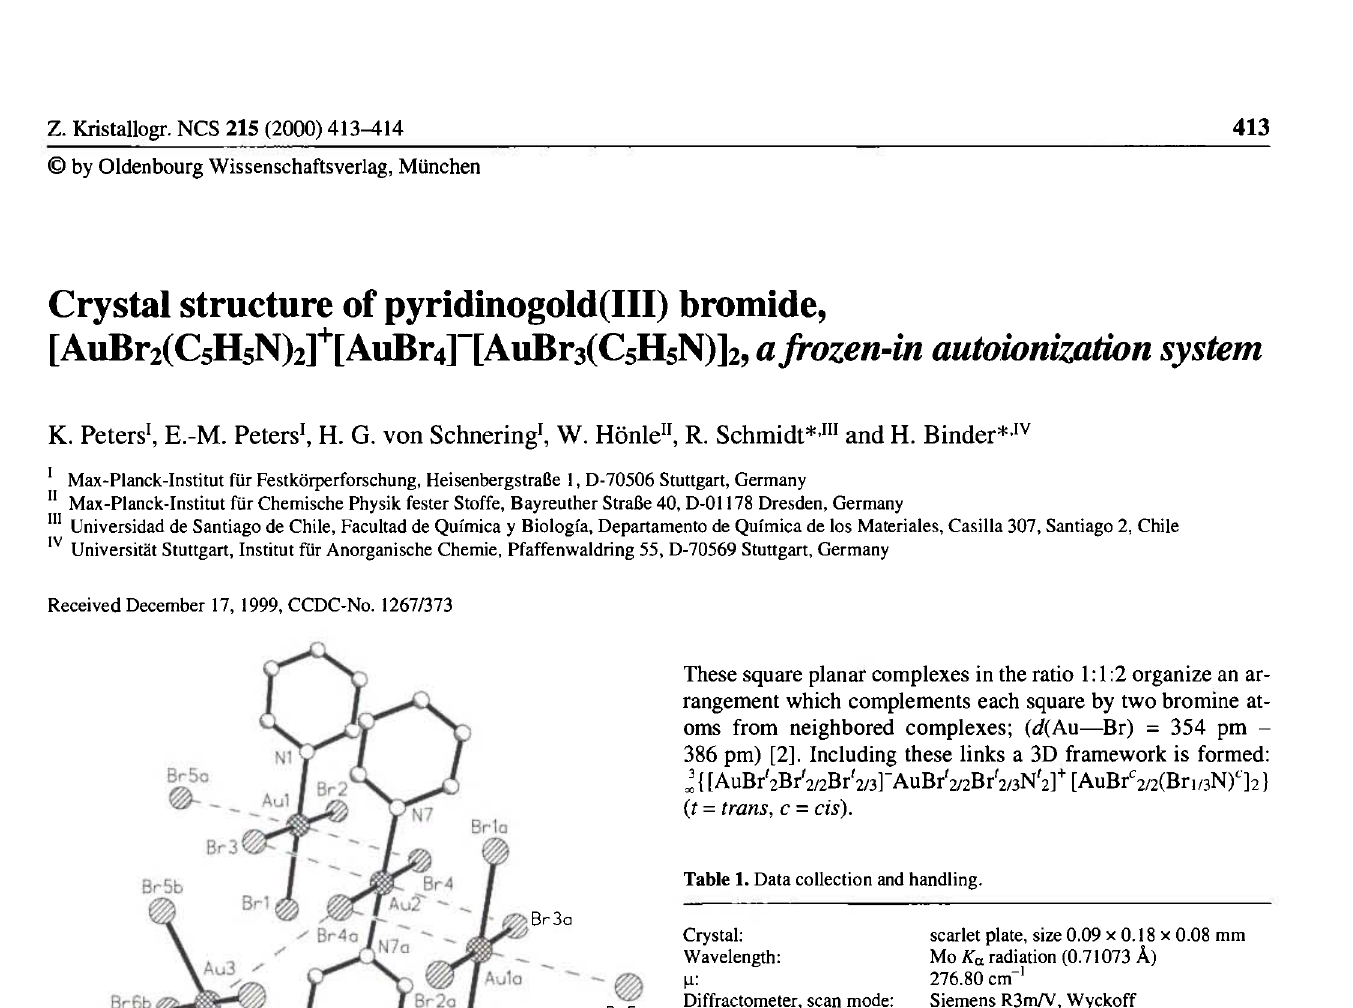
Table 2. Atomic coordinates and displacement parameters (in Ä 2